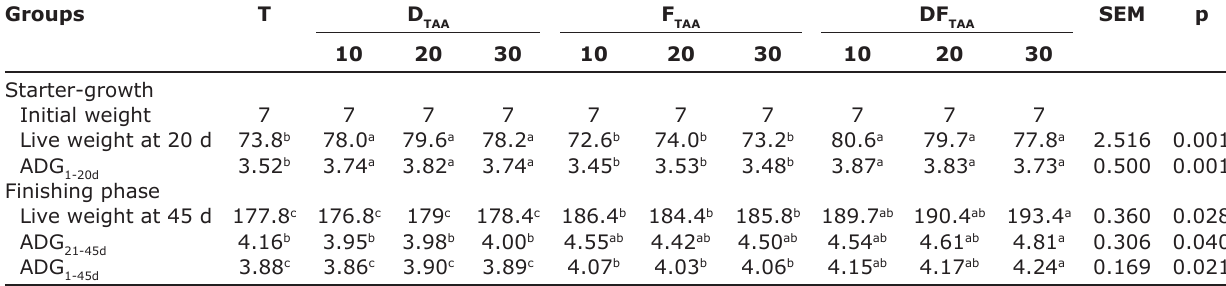
Table-4: Effect of substitution of soybean meal with apricot kernel meal on quail weight growth (g) and average daily gain (ADG g/d/subject). Groups